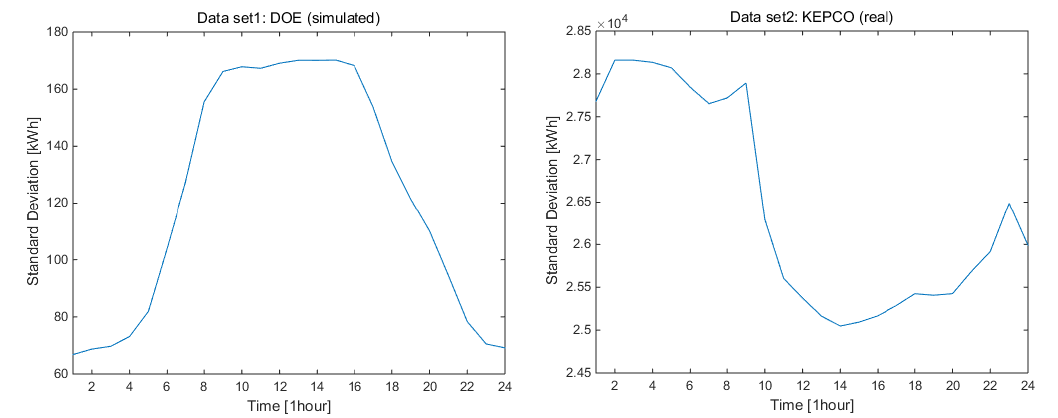
Figure 3. Standard deviation of power load on each